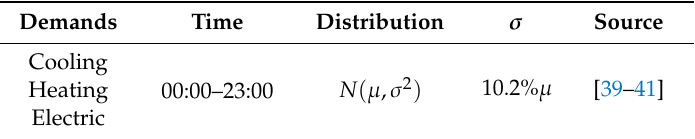
Table A3. The probability distribution of demand.